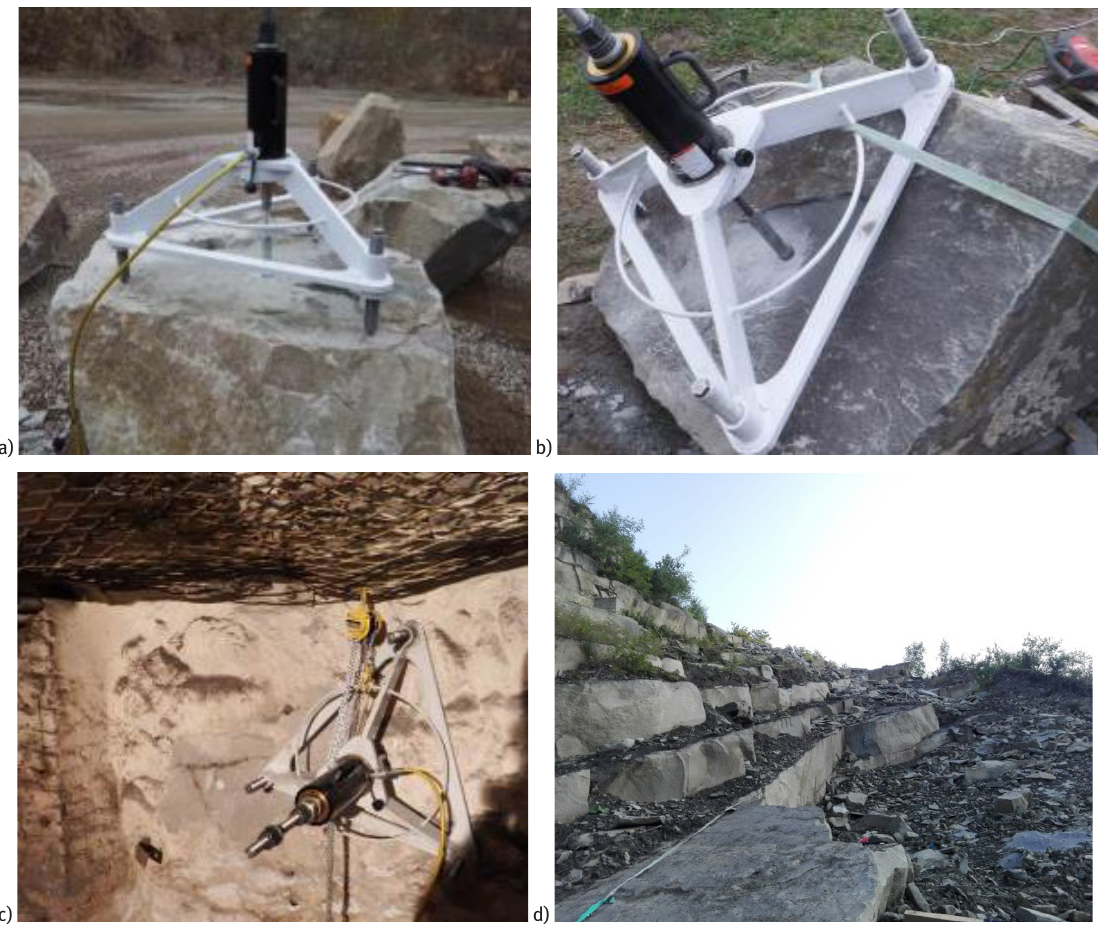
Figure 9: Place of tests: a) ZALAS, b) BRACISZÓW, c) GUIDO, d)